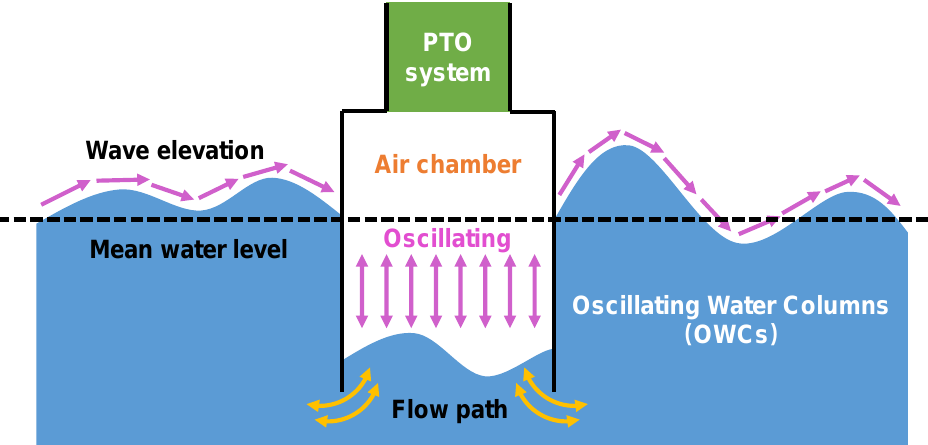
Figure 19. The schematic diagram of a well-type